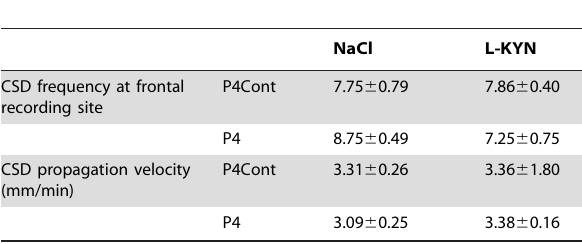
Table 2. CSD frequency at the frontal recording site and CSD propagation velocity in ovariectomized rats treated or not with